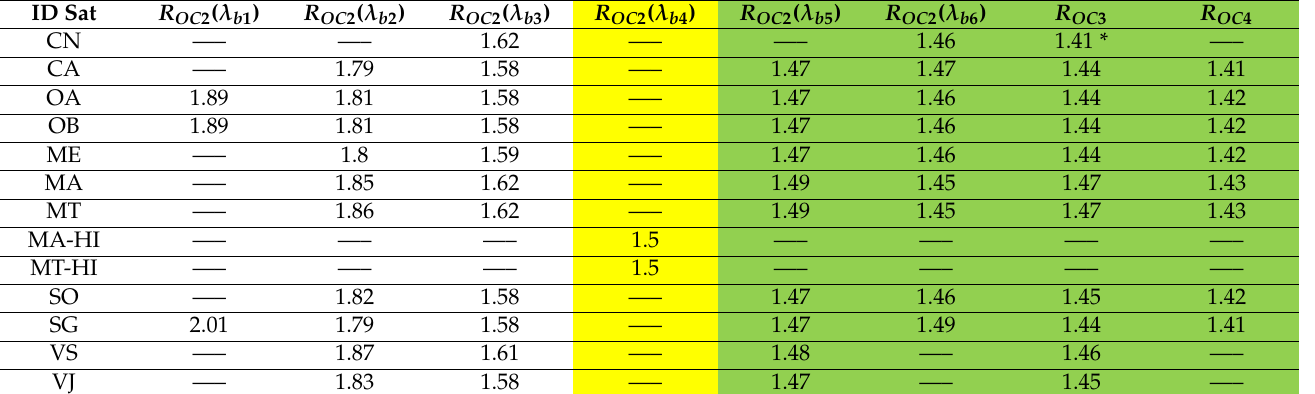
Table 7. MAEL values for comparison between measured in situ chl-a concentrations ( C ins ) and estimated remote sensed chl-a concentrations (C rs ) calculated using Formula (8) for different band ratios. Columns with the best results are highlighted in green, and columns with mediocre, but acceptable results are highlighted in yellow.